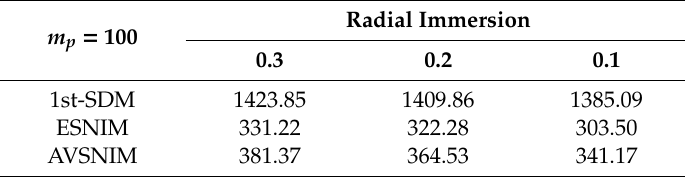
Table 1. Calculation time required for the 1st-SDM, ESNIM, and VSNIM (unit: s). m = 100 p m p =